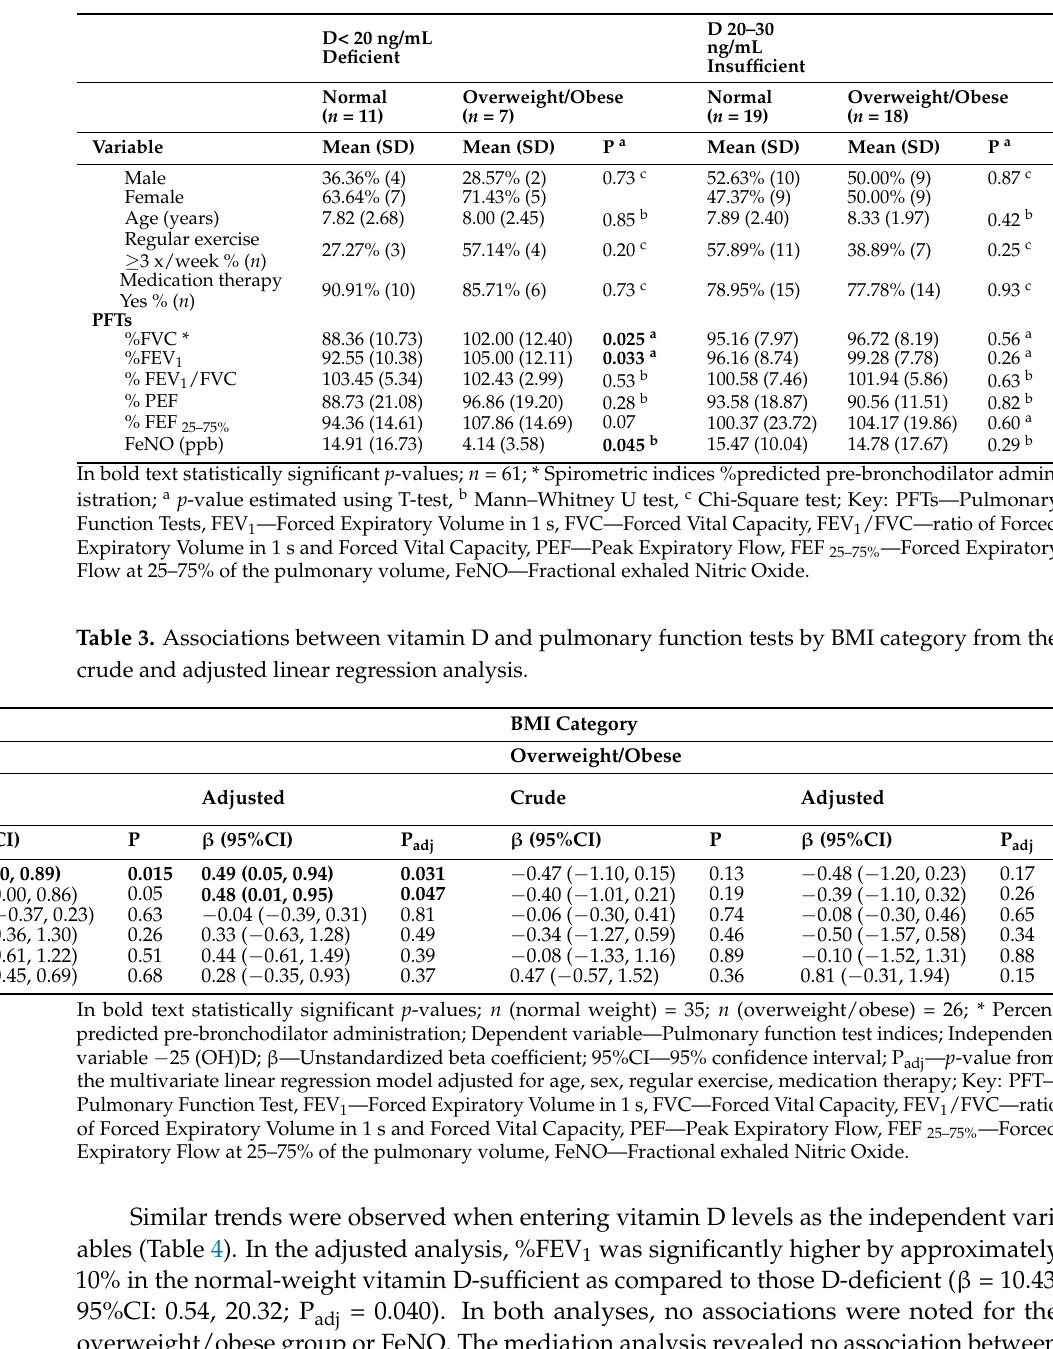
Table 2. Population characteristics according to BMI category and by vitamin D level.